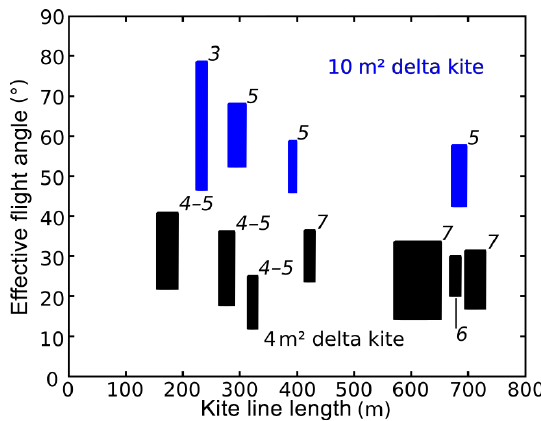
Figure 7. Observed flight angles for the two kites and various wind speed conditions and line lengths. Wind conditions (in italics) are expressed in the Beaufort scale. Measured flight angles were grouped in min/max boxes for each flight. Blue boxes represent the behaviour of the 10m 2 kite and black boxes represent the behaviour of the 4m 2 kite.